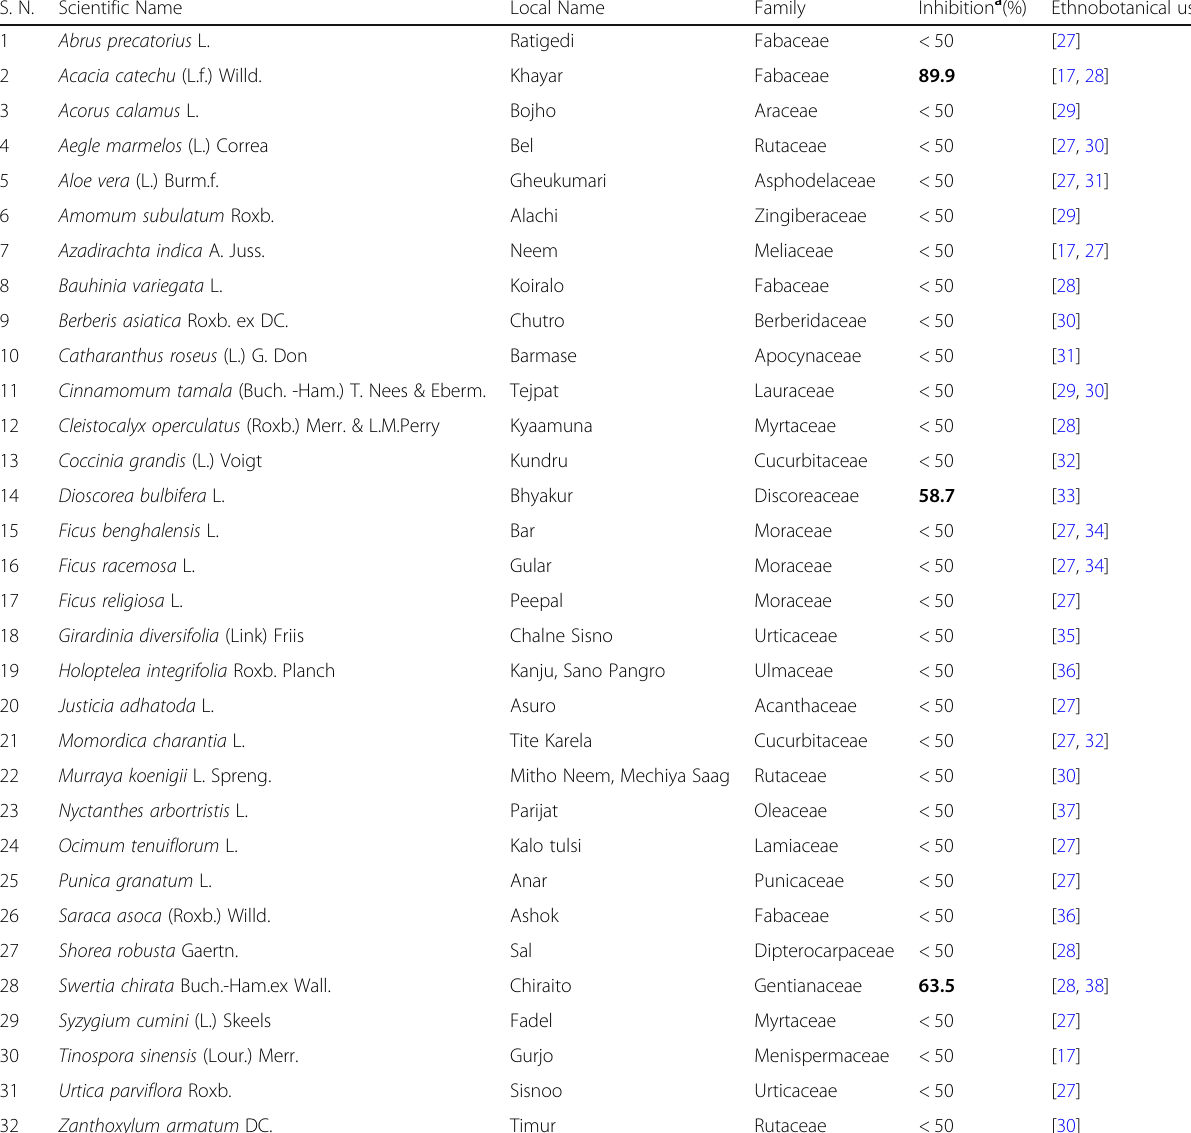
Table 1 List of plants selected for the study of α -amylase inhibitory potentials of their methanolic extracts